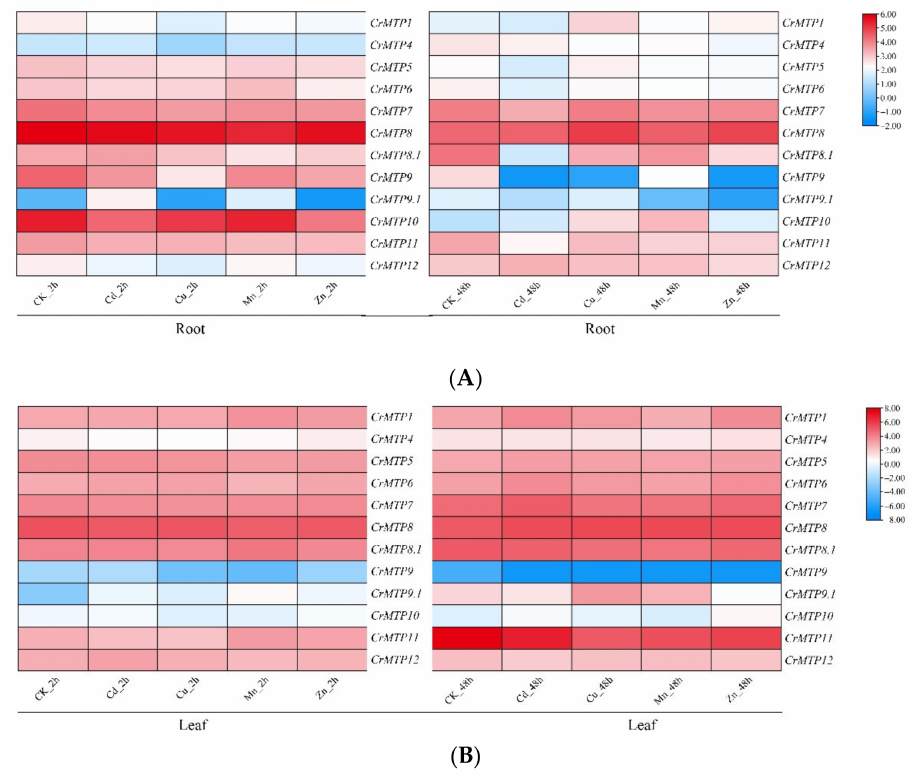
Figure 8. Heatmaps showing the expression patterns of CrMTPs under different HM challenges (0.1 mM CdCl 2 , 0.1 mM CuSO 4 , 1 mM MnCl 2 , and 0.5 mM ZnSO 4 ) both in roots ( A ) and in leaves ( B ). The expression level of each gene is shown with the values of FPKM (log2). Red denotes high expression levels, and blue denotes low expression levels.